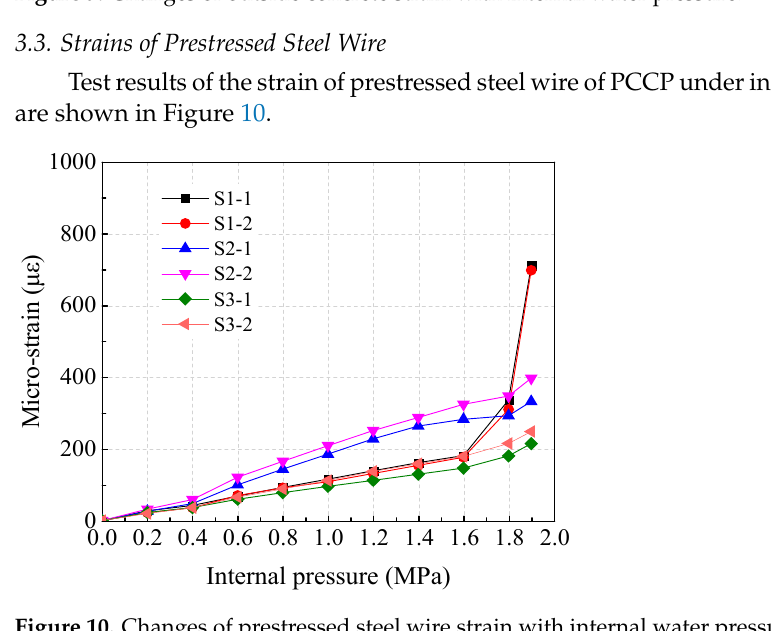
Figure 10. Changes of prestressed steel wire strain with internal water pressure.